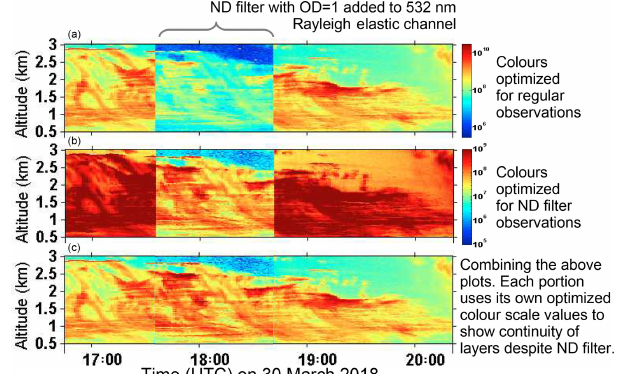
Figure 8. On 30 March 2018, during an event with the same fea- tures as previous examples, we placed an ND1 neutral density filter in front of the 532nm Rayleigh elastic PMT for 1h. The stripes re- mained visible throughout the test. This is extra assurance that the PMT is not being saturated. Panel (a) has a colour bar which is op- timized to show the stripes in the clouds before and after the ND filter test. Panel (b) has a colour bar which is optimized to show the stripes during the ND filter test when count rates were lower by a factor of about 10. Panel (c) is a combination of the first two plots. Measurements from all times during the test are shown at their own optimal colour scale so that individual layers may be identified and followed throughout the